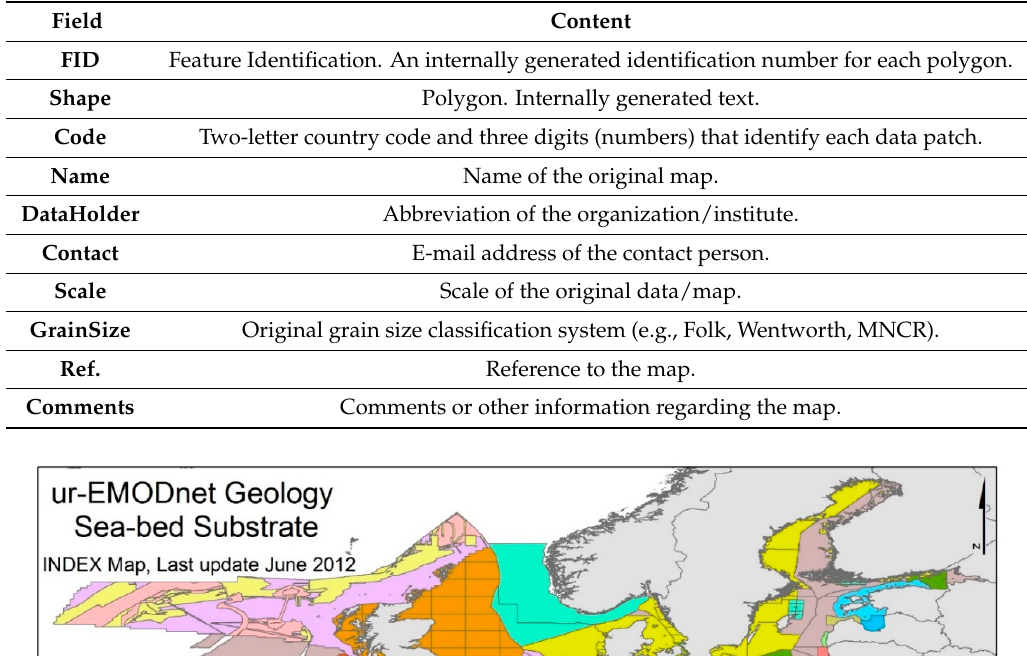
Table 1. The index shapefile/database includes an attribute table detailing basic information on each dataset.